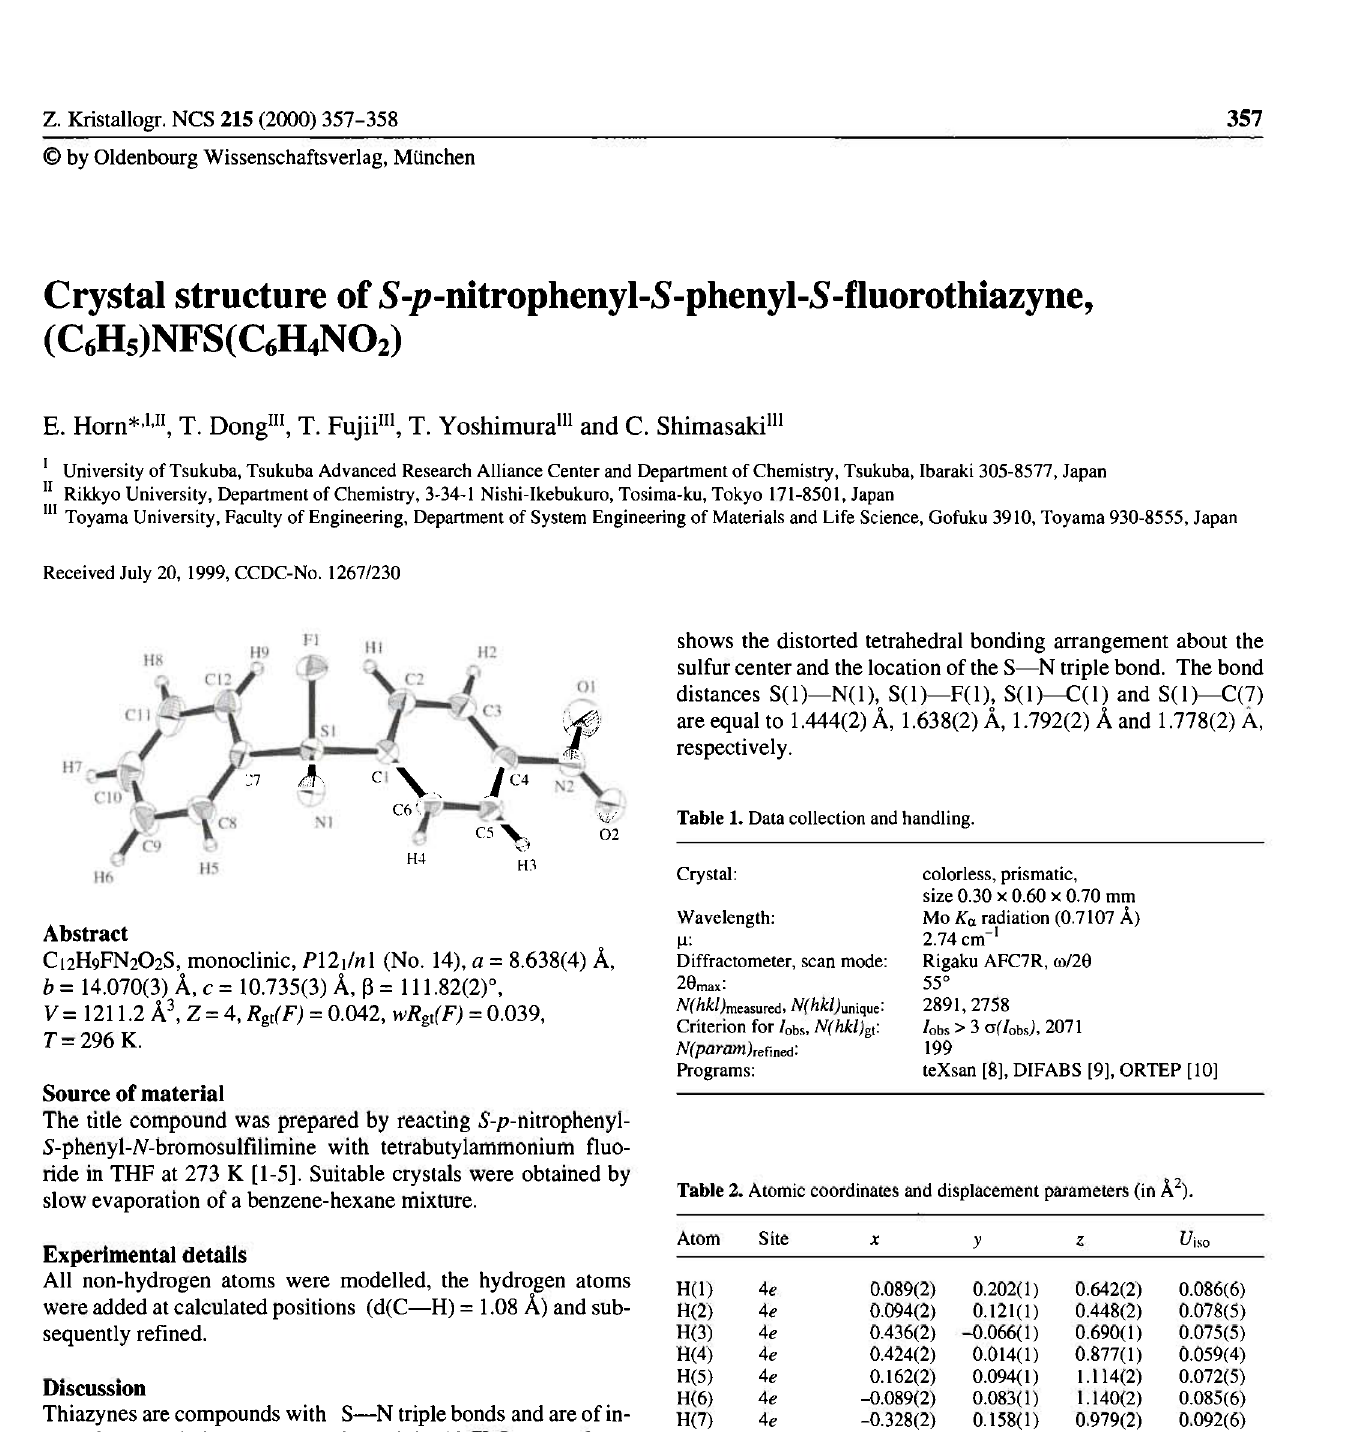
Table 2. Atomic coordinates and displacement parameters (in Ä 2